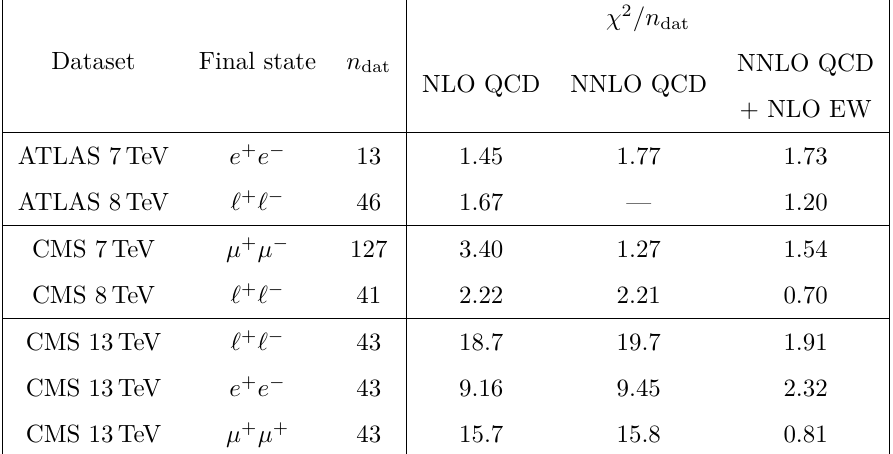
Table 3 . The values of the χ 2 per data point evaluated for the high-mass DY datasets listed in table 2, using theoretical predictions computed at different perturbative accuracy. The PDF sets used here are NNPDF31_nlo_as_0118 , NNPDF31_nnlo_as_0118 and NNPDF31_nnlo_as_0118_luxqed for the NLO QCD, NNLO QCD and NNLO QCD + NLO EW predictions respectively. For CMS 13 TeV, where different final states are available, we indicate the χ 2 values for each of them. For the ATLAS 8 TeV data, we only evaluated the combined NNLO QCD + NLO EW correction, and hence the pure NNLO QCD result is not